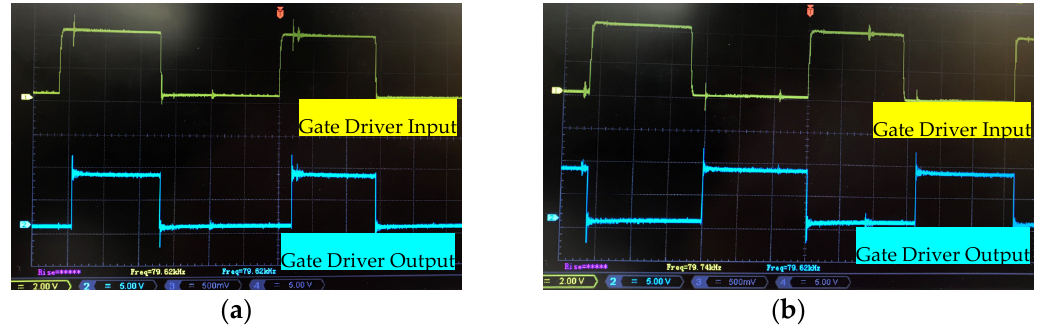
Figure 9. Yellow signals: Gate driver input signal, Blue signals: ( a ) High-level voltage of gate driver output in ON mode, controlling the top transistor of the half-bridge inverter; ( b ) low-level voltage of gate driver output in OFF mode, controlling the bottom transistor of the half-bridge inverter.